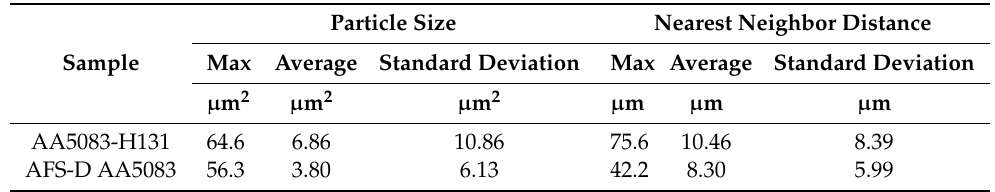
Table 2. Particle analysis comparing constitutive particles in the AA5083-H131 feedstock and